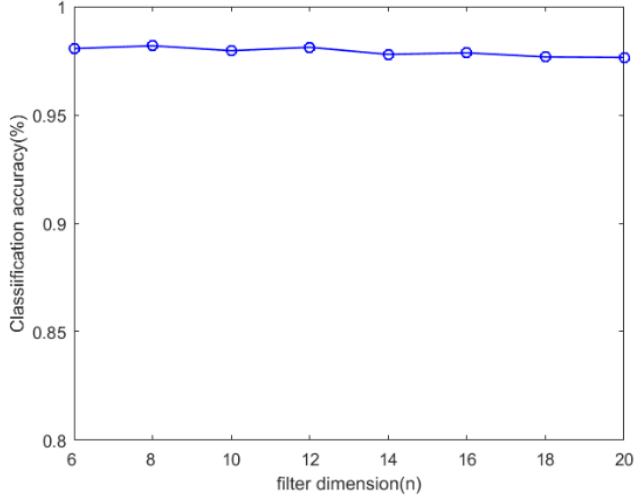
Figure 6. Classification accuracy based on variable dictionary filter dimension.